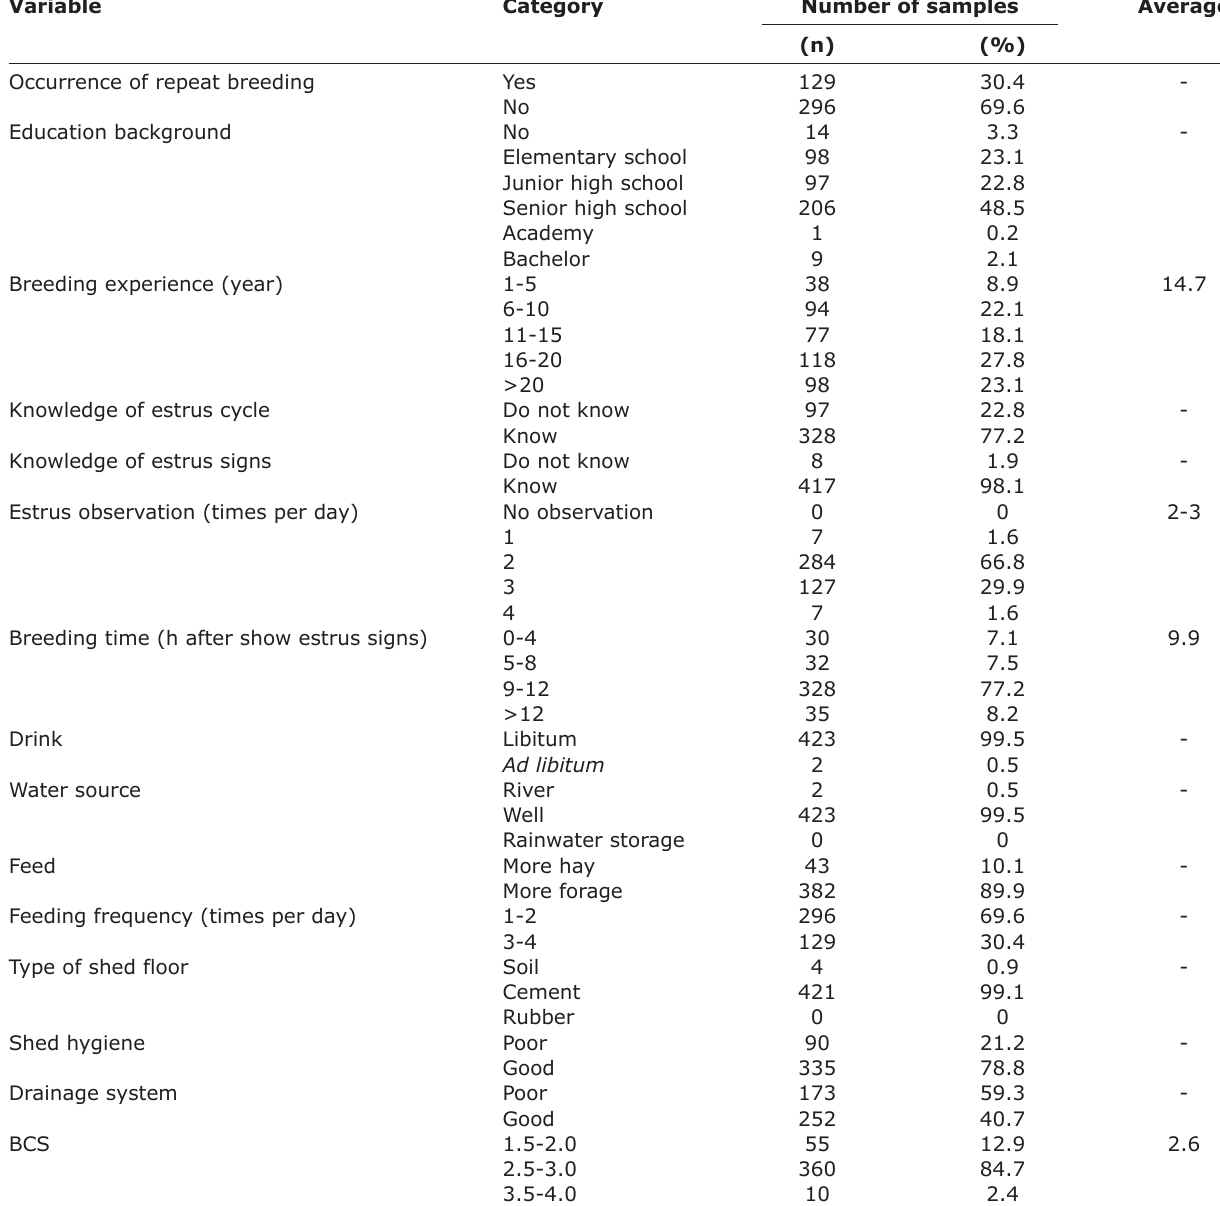
Table-2: Descriptive data of risk factors for repeat breeding in beef cattle in Sleman Regency, Indonesia.